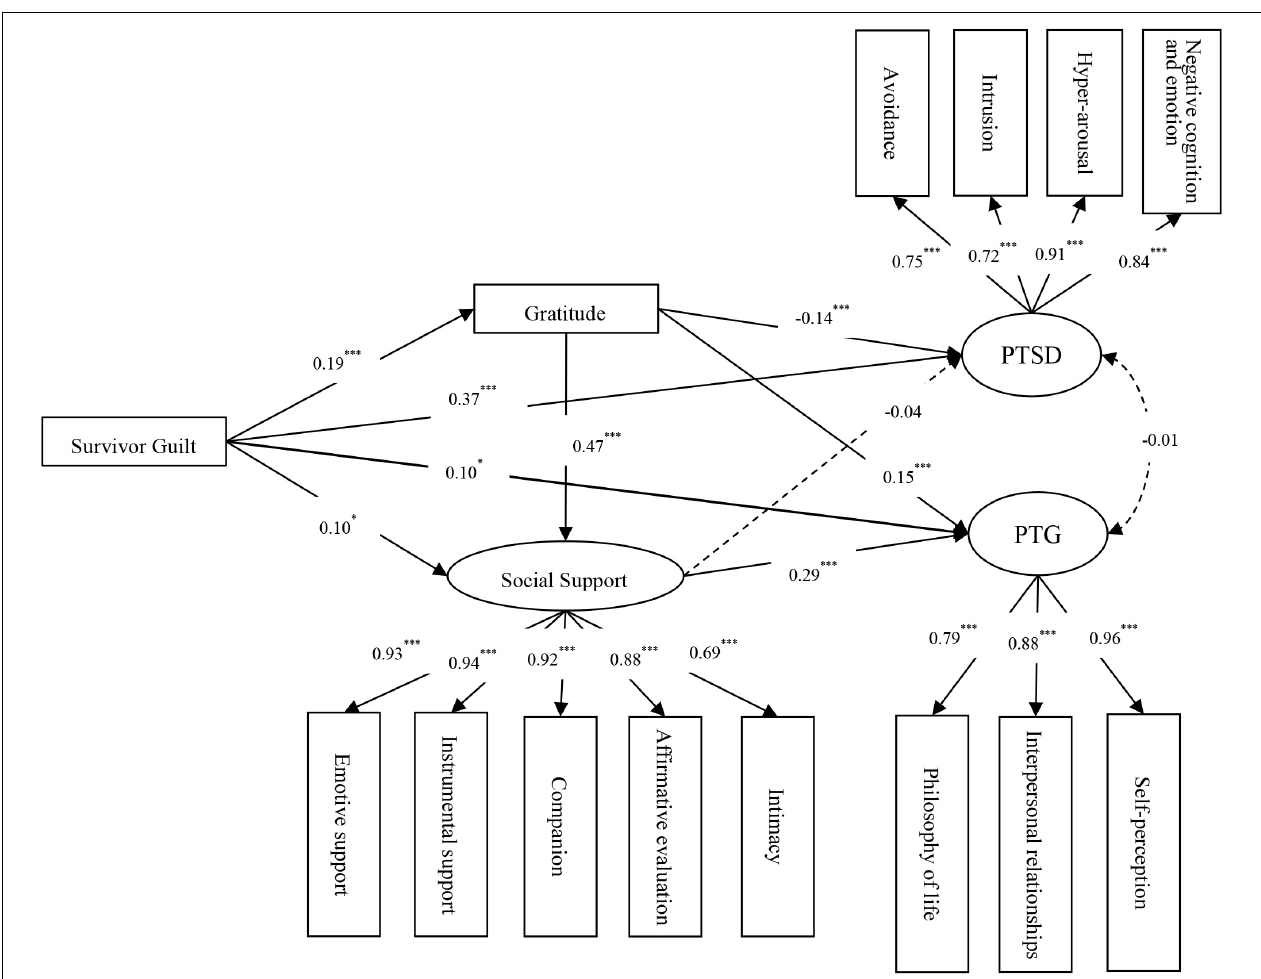
FIGURE 1 | The multiple indirect effects model. PTSD, posttraumatic stress disorders; PTG, posttraumatic growth. ∗∗∗ p < 0.001; ∗ p < 0.05.